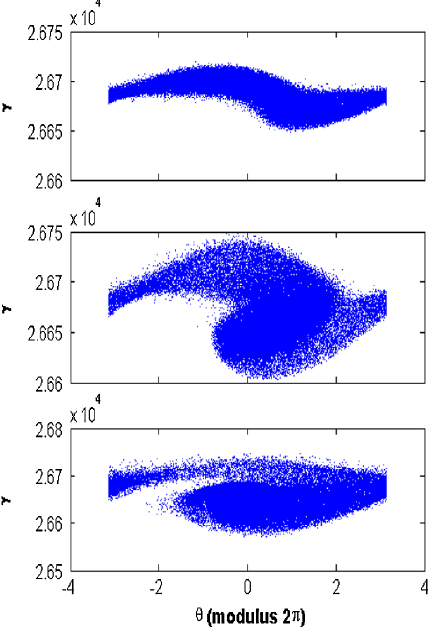
FIG. 4. The electron beam distribution in the phase space of ( (cid:11) , (cid:1) ) at the initial saturation location (top), and a distance of ¼ 4 : 7 m (middle) and 2 z z r saturation for Case A, obtained by GENESIS single-frequency